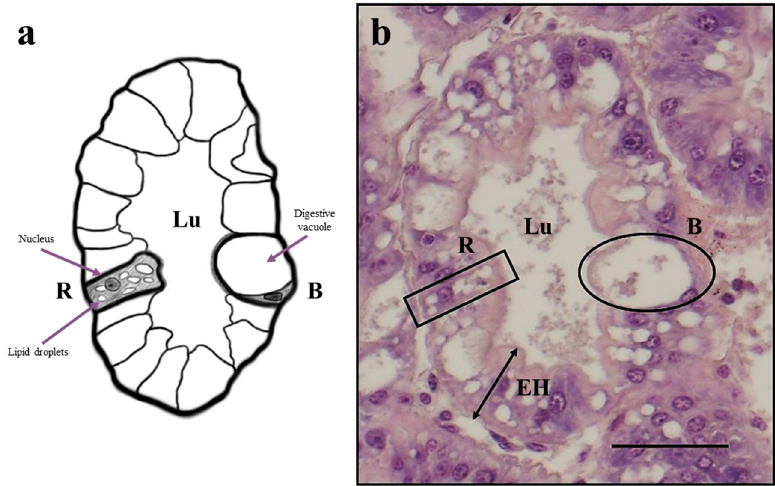
Figure 1. ( a ) Schematic representation of transversal section of hepatopancreas tubule from high- lighting a detailed example of R cell and B cell (author: Matteo Zarantoniello). ( b ) Example of histomorphology of transversal section of a hepatopancreas tubule (middle portion) from HM0 group. Scale bar: 50 µm. Abbreviations: R, R cell; B, B cell; EH, epithelium height; Lu, lumen.